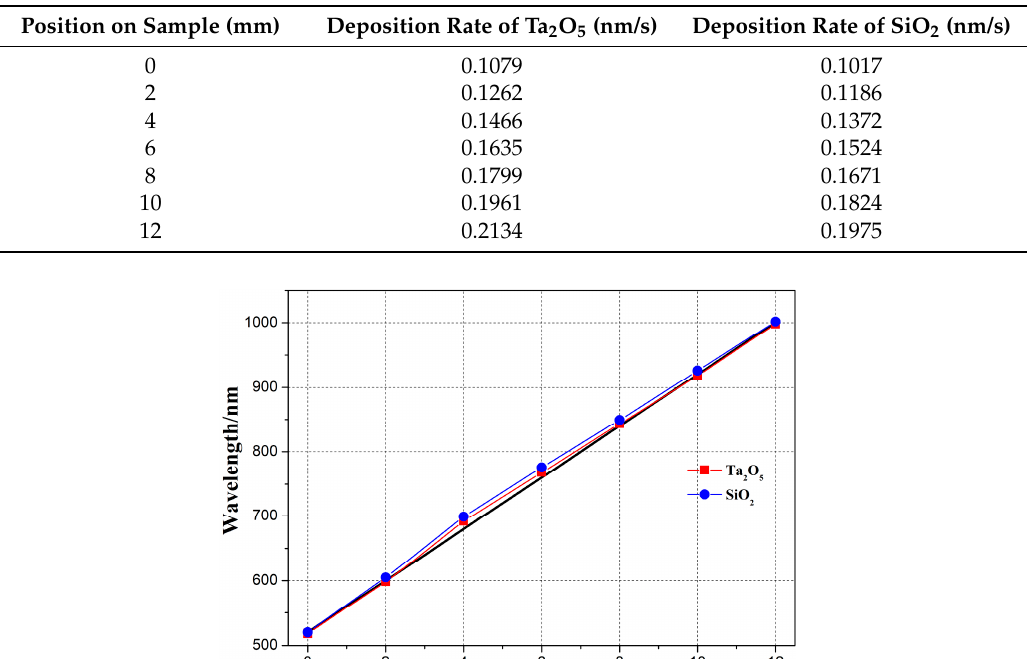
Figure 6. Linear change rate of the thickness of the two materials after match correction.